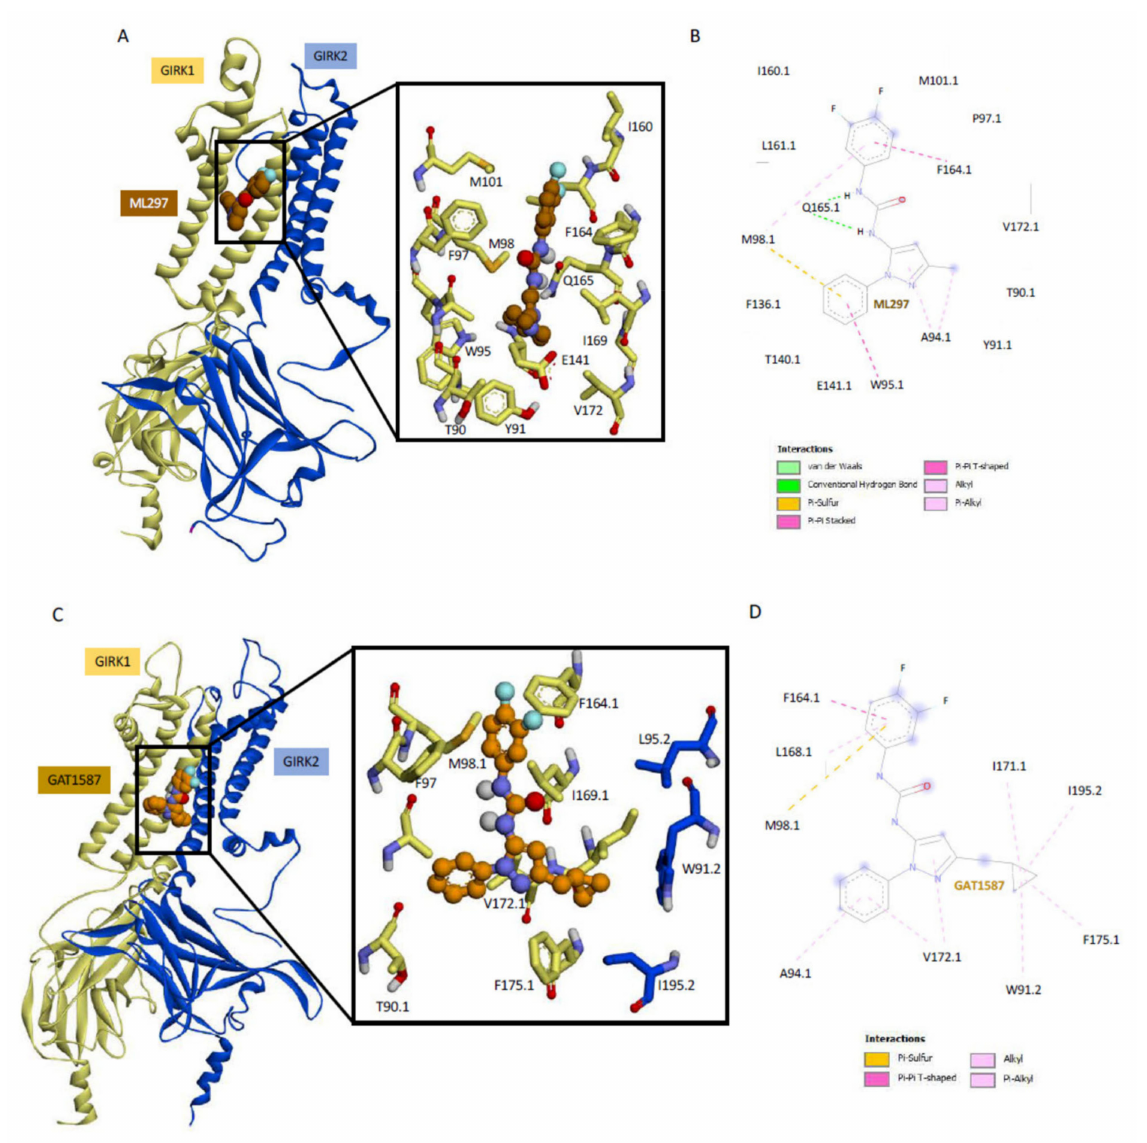
Figure 2. GAT1587 binding site along the TM helices in the GIRK1/2 heterotetramer.( A ) Equilibrium binding pose for ML297 when complexed with PIP 2 GIRK1/2 after 300 ns of stochastic dynamics. ( B ) A 2D schematic representation of the compound’s binding pose depicting protein ligand interac- tions. ( C ) Equilibrium binding pose for GAT1587 when complexed with PIP 2 GIRK1/2 after 300 ns of stochastic dynamics. ( D ) A 2D schematic representation of the compounds binding pose depicting protein ligand